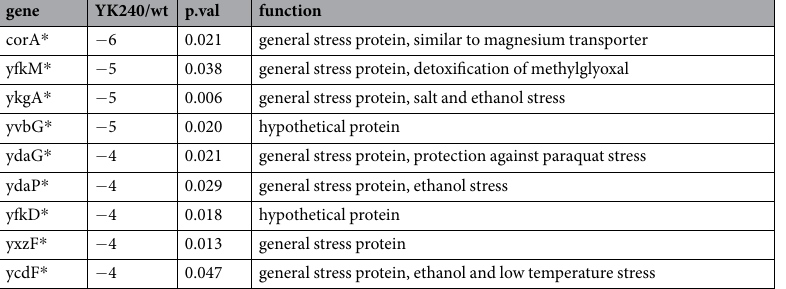
Table 1. Transcriptome analysis of SepF overexpression. Genes are listed based on expression fold difference and selected for > 4-fold expression difference between wild type (wt) and strain YK240 (P xyl-sepF ) grown in the presence of 1.5% xylose to induce SepF. Genes with adjusted P-value (p.val) larger than 0.05 were discarded. Genes marked with ‘ * ’ belong to the SigB